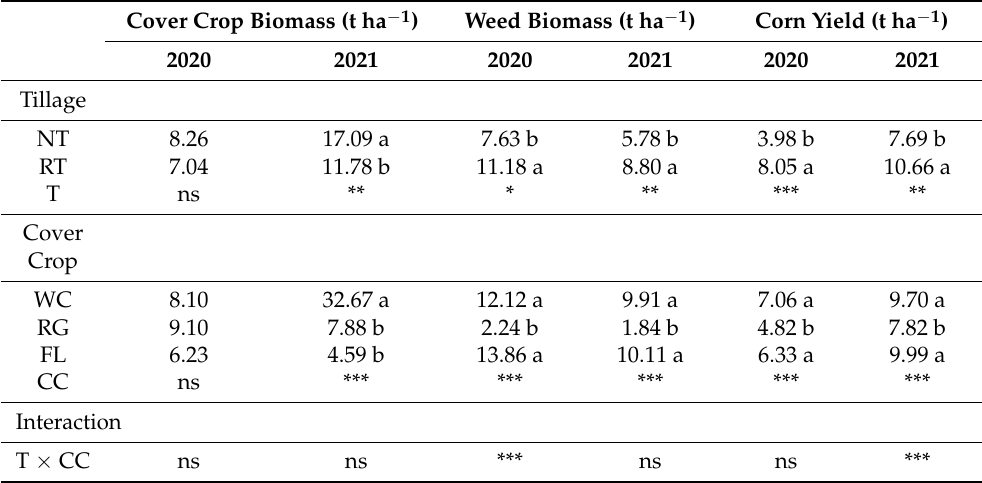
Table 1. Effect of different tillage and cover crops on cover crop biomass, corn yield, and weed biomass [mean (SD), n =